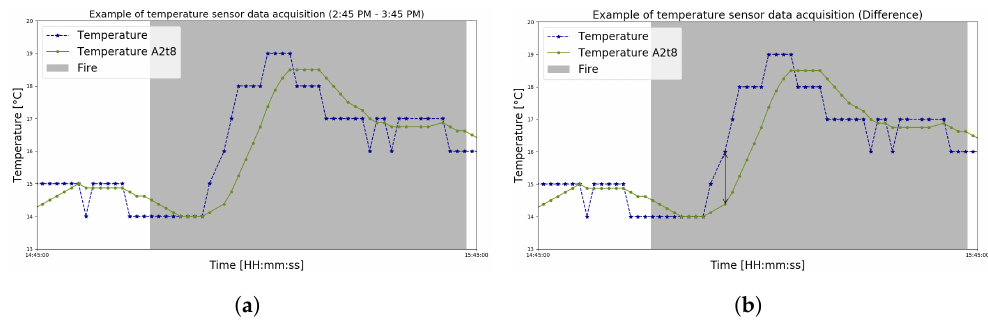
Figure 8. Zoomed plotting of the sensor module’s temperature data that exemplifies the difference proposed by approach A 2 through n = 8. ( a ) The raw and smoothed temperature sensor during a fire test. ( b ) Black arrow with unknown D size marking the difference between raw and smoothed data.